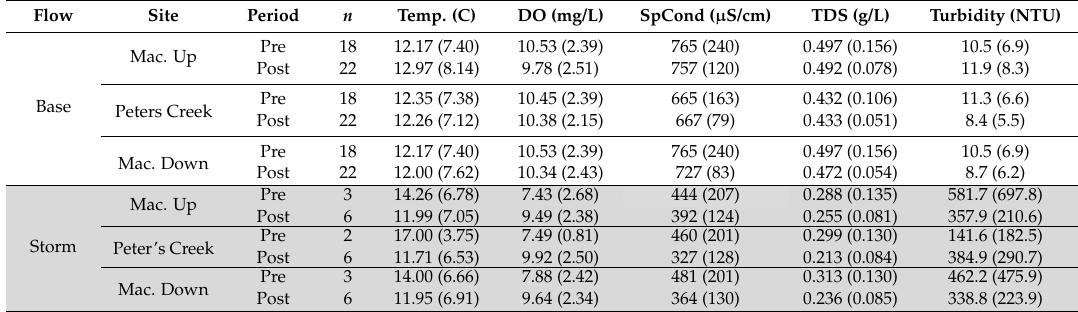
Table 4. Grand means (1 SD) of water quality parameters at the Middle Macatawa wetland restoration site. Values in the top half of each cell represent prerestoration (Apr. 2014–Sep. 2015); values in the bottom half represent postrestoration (Oct. 2015–Nov. 2017). Storm flow data shown in gray shade.